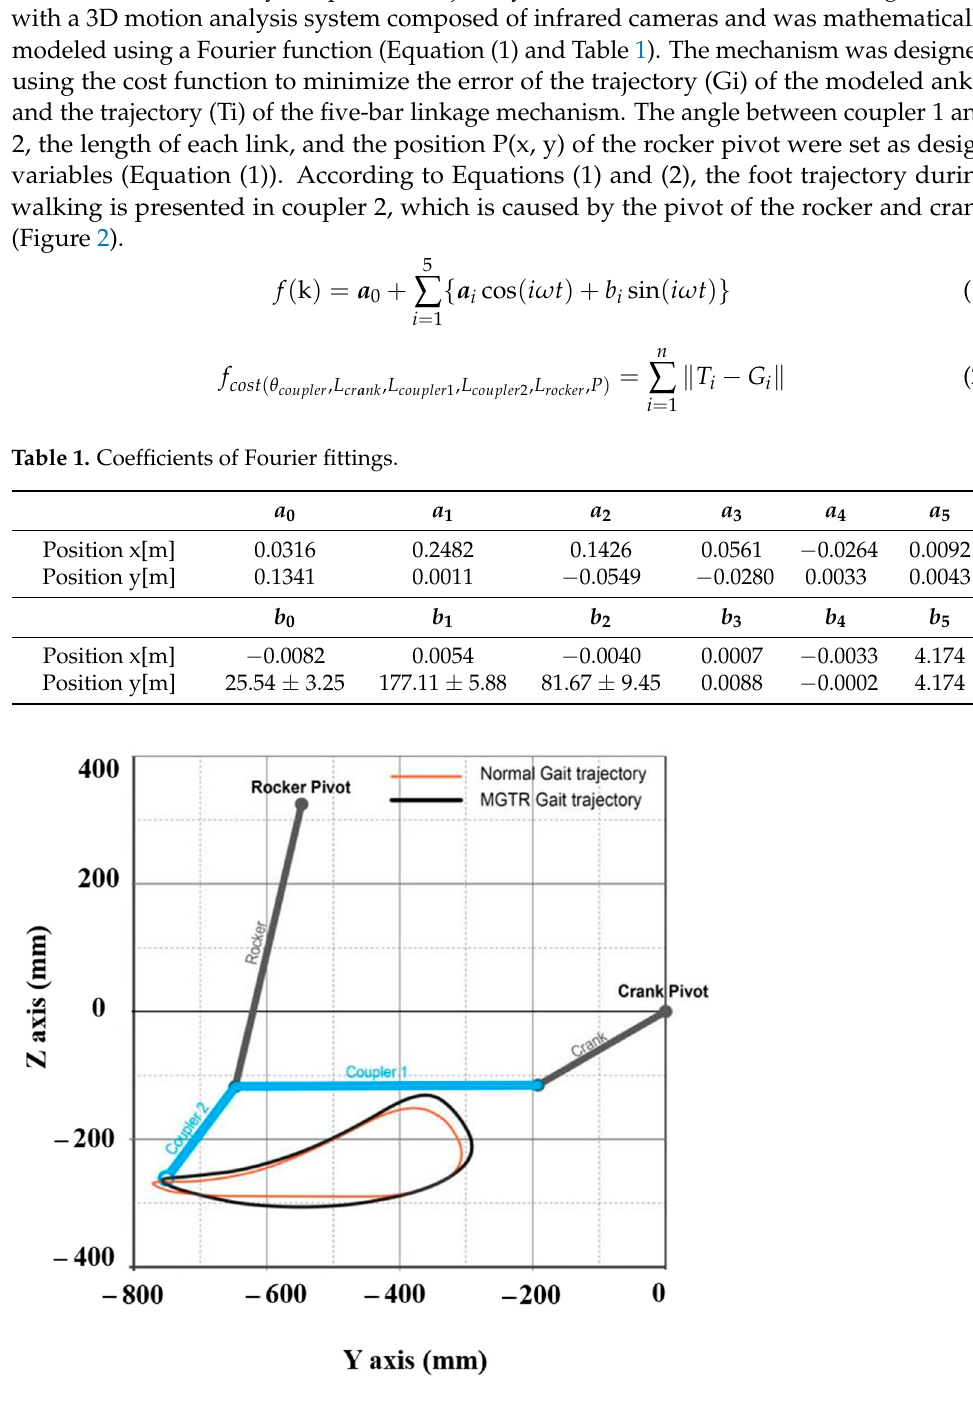
Figure 2. Result of implemented gait trajectory.